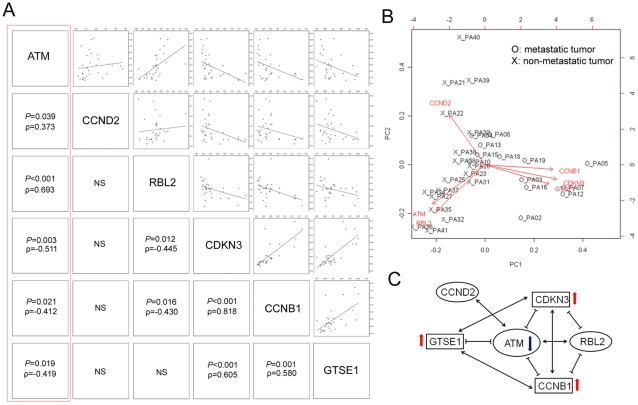
Correlation analysis of six genes reveals relationship with each other.Expression of ATM was only significantly associated with all other 5 genes (A). Principal component analysis showed separation of metastatic and non-metastatic neuroendocrine tumors with contributing genes (B). Network interaction diagram constructed based on correlation of six genes (C).